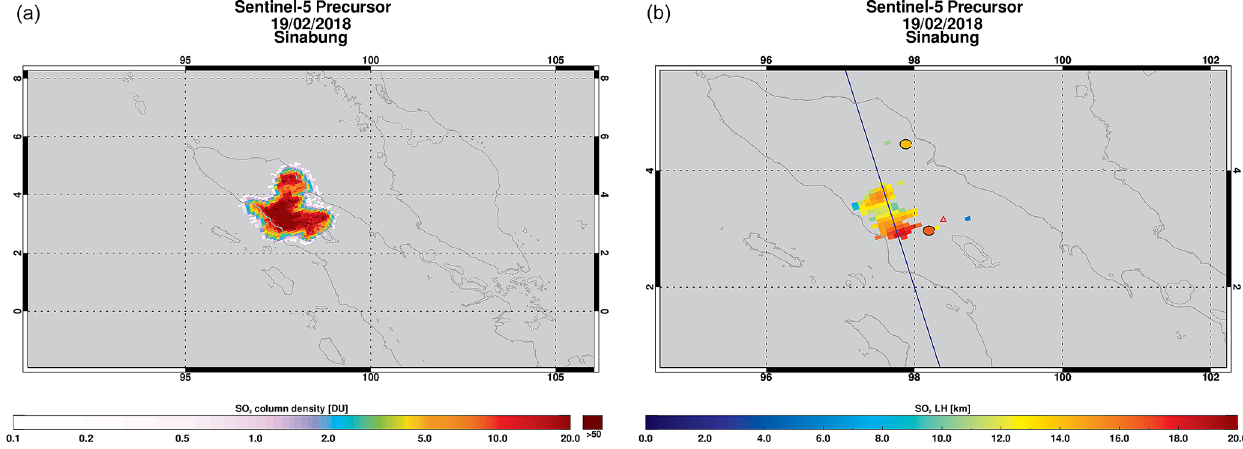
Figure 6. SO 2 VCD (a) and SO 2 LH (b) for the TROPOMI measurements of the Sinabung volcano on 19 February 2018, at an overpass time of around 06:30UTC. SO 2 LH results are only shown for VCD values greater than or equal to 20DU. In panel (b) MLS/Aura results (the two colored circles) and the CALIPSO ground track (cf. Fig. 7) are shown.